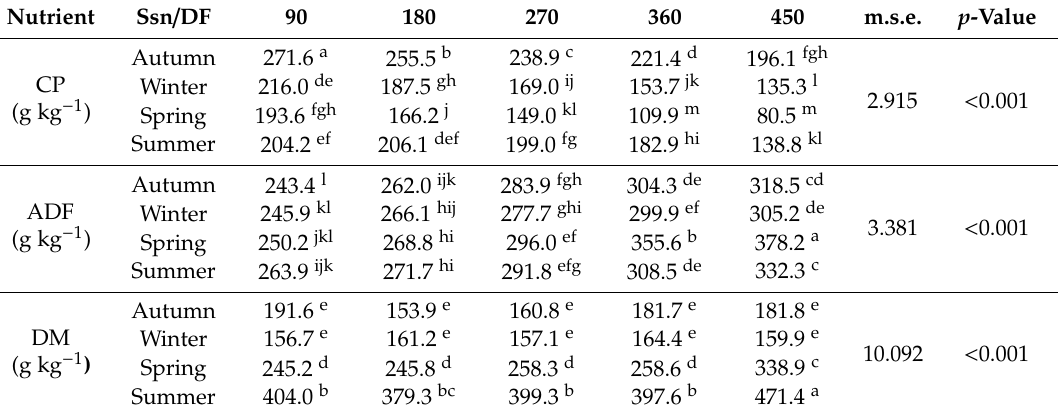
B. valdivianus (Figure 3c). The lowest concentration was measured under high DF (90 AGDD) and increased with decreasing DF. Table 3. Interaction between season and defoliation frequency by nutritional value.